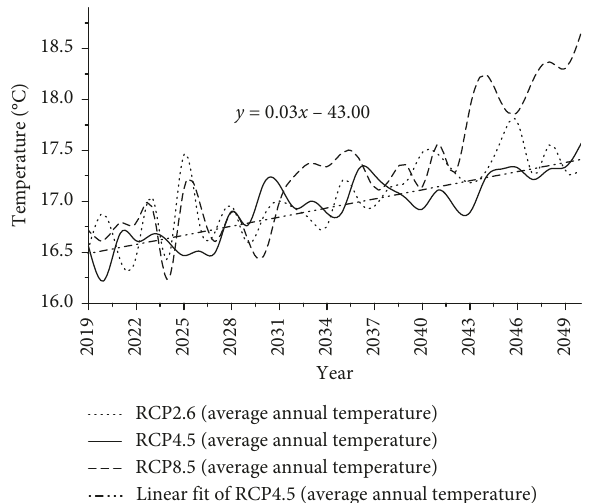
Figure 8: Evolution trends of the average annual temperature from 2019 to 2050.